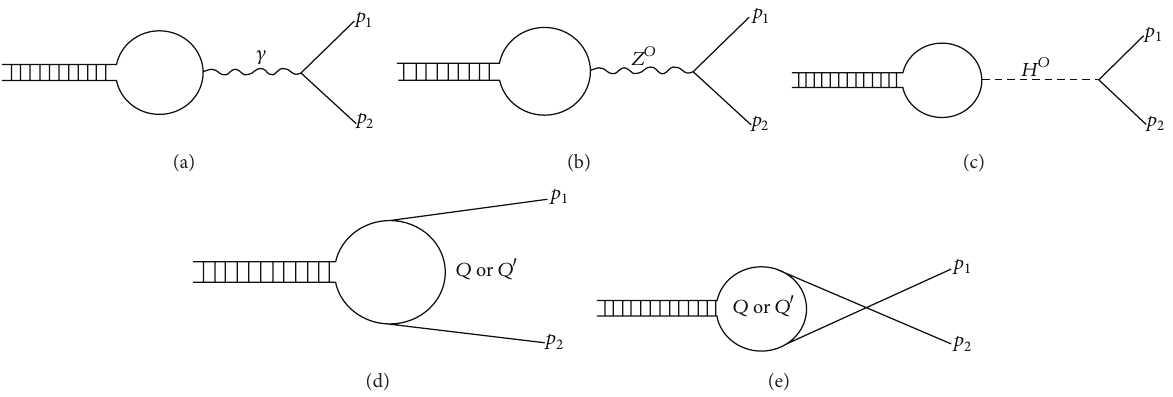
Figure 3: First-order diagrams for the 𝜂 𝑄 → 𝑝 1 𝑝 2 decays, where 𝑝 1 and 𝑝 2 can be a gauge boson pair, a fermion-antifermion pair, a gauge- Higgs boson pair, or a pair of Higgs bosons. The strong decay mode 𝜂 𝑄 → 𝑔𝑔 is also allowed but not shown above. The (a), (b), and (c) diagrams denote decays via 𝛾 , 𝑍 , or 𝐻 exchange in the 𝑠 -channel, while (d) and (e) correspond to the 𝑝 1 𝑝 2 decays involving quark exchange in the 𝑡 - and 𝑢 -channels. Figure from [30].